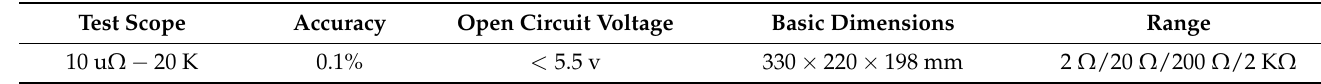
Figure 6. Experimental platform of the rigid-flexible coupling manipulator. Table 2. Relevant parameters of RK2511n + DC resistance tester.